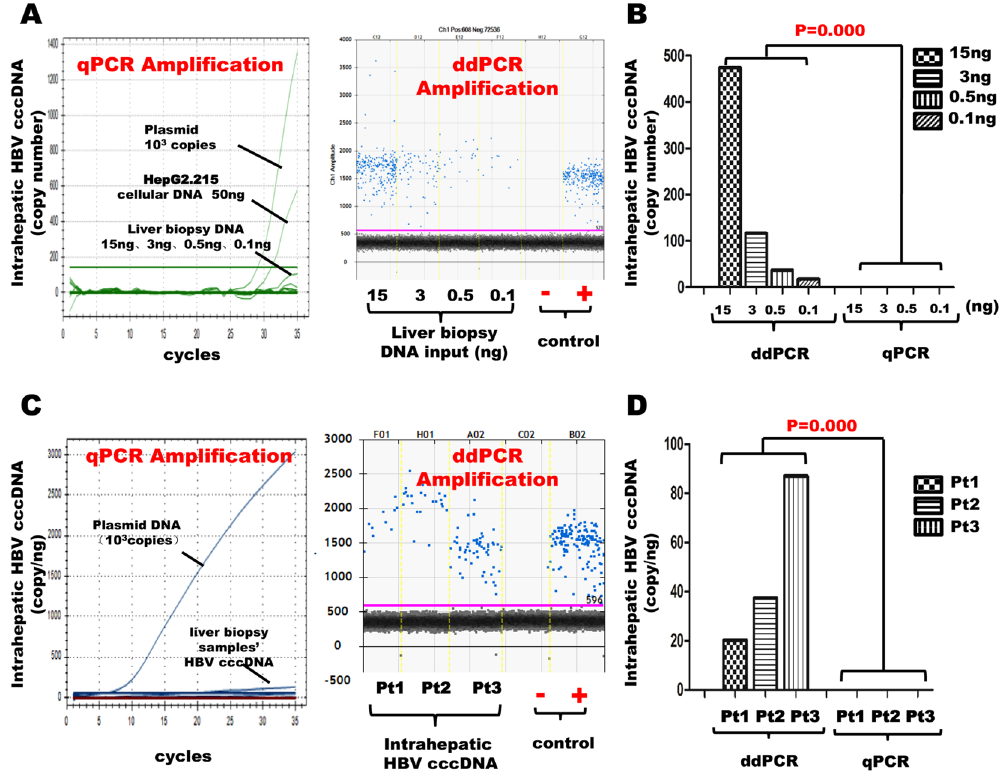
Figure 1. Comparison of cccDNA quantification assay using a ddPCR versus a qPCR amplification system. ( A ) HBV cccDNA amplification with either the qPCR or ddPCR system. ( B ) Quantification of copy numbers of HBV cccDNA detected by either the ddPCR or qPCR system. ( C ) Detection and quantification ( D ) of HBV cccDNA from three different CHB patients by the ddPCR or qPCR